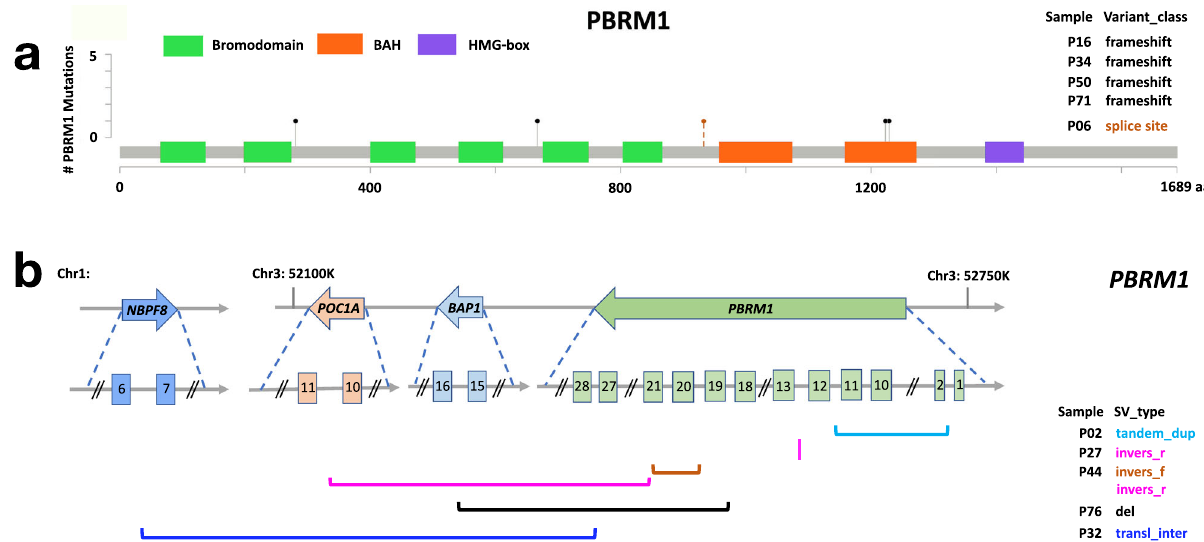
Fig. 4 Summary of PBRM1 alterations identi fi ed in ten skull-base chordoma patients. a Lollipop plots depict nonsynonymous mutations found in PBRM1 ( fi ve patients), showing identi fi ed mutations relative to a schematic representation of the gene. Each lollipop denotes a unique mutation and the length of the line re fl ects the number of samples with the mutation. The colored boxes are functional domains of the protein. The splicing mutation, which is located in a noncoding region, is shown with a broken line. b Structural variants (SVs) found in PBRM1 ( fi ve patients) detected by Meerkat. Different SV types are indicated by different color